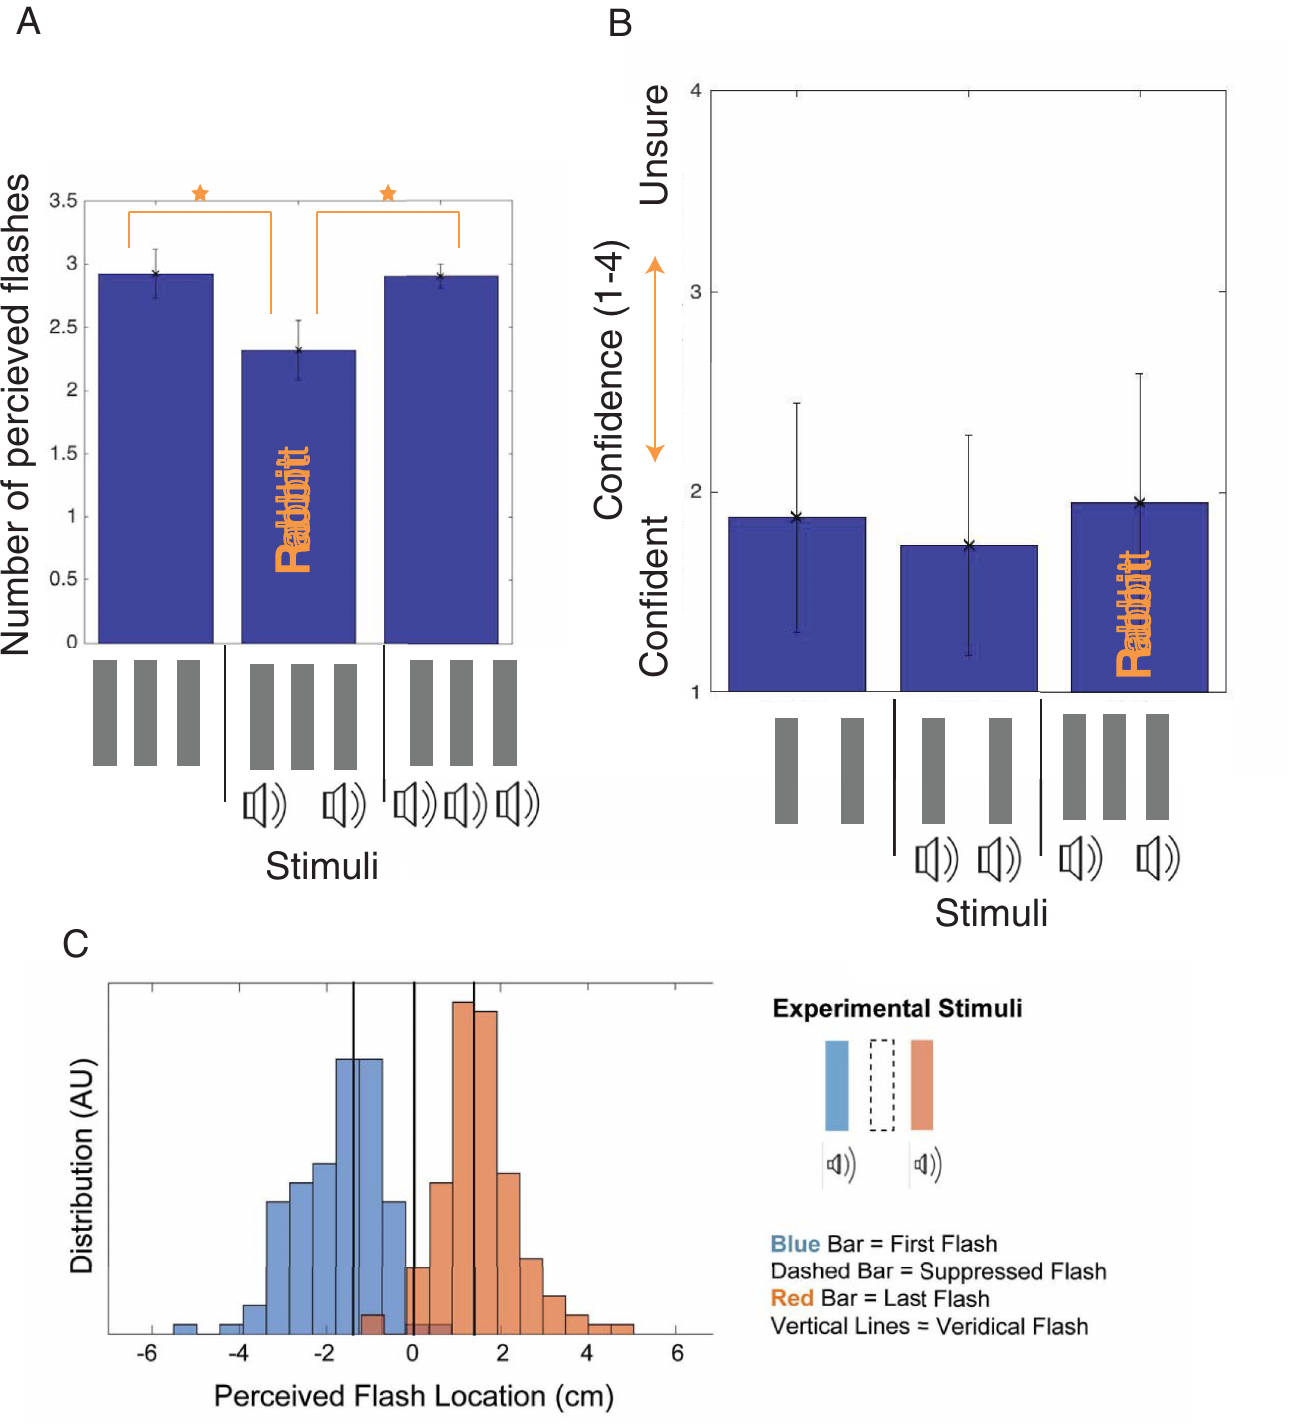
Fig 4. Invisible AV rabbit results. Fig 4A plots the number of flashes perceived for several beep and flash stimuli in comparison to the Invisible AV Rabbit stimulus (Experiment 2.1 and 2.2). Fig 4B shows the confidence rating reported for perceiving two flashes for the Invisible AV Rabbit stimulus in comparison to non-illusory stimuli. Fig 4C indicates the reported flash locations (in centimeters) across participants for the Invisible AV Rabbit stimulus, when two flashes are reported. Error bars are standard deviation.